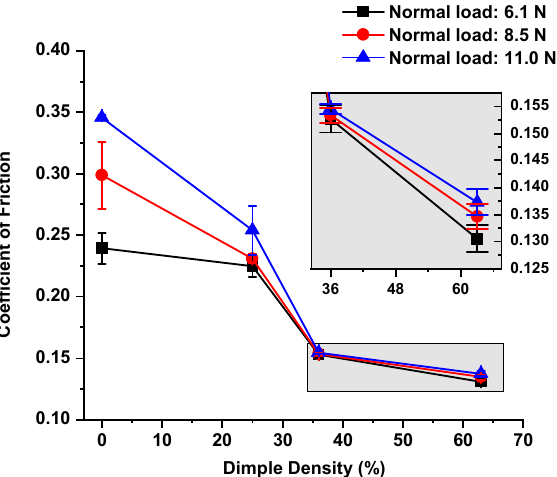
Figure 4. Comparison of CoFs in the non-textured case and textured cases under dry conditions and normal loads of 6.1 N, 8.5 N, and 11.0 N.